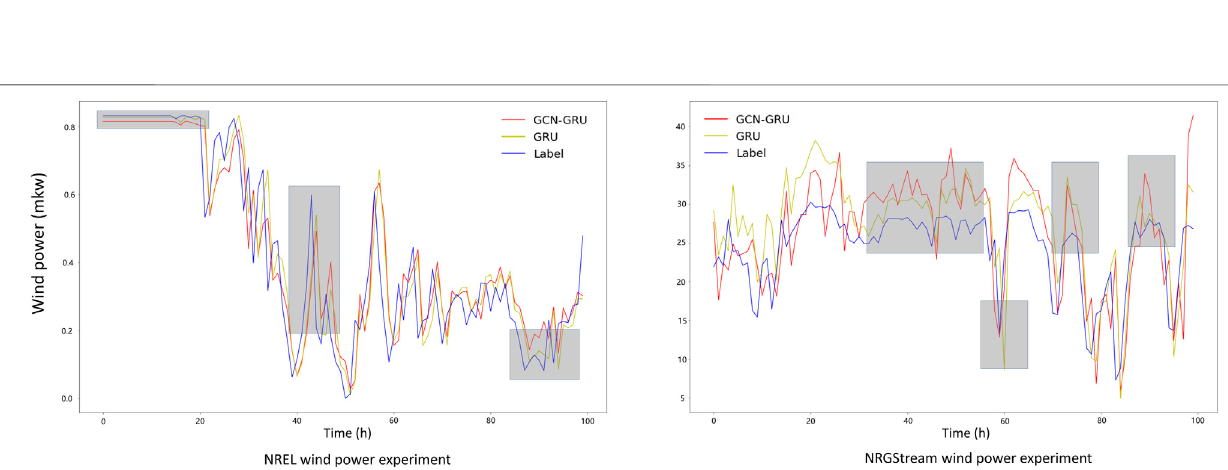
Frontiers in Environmental Science |